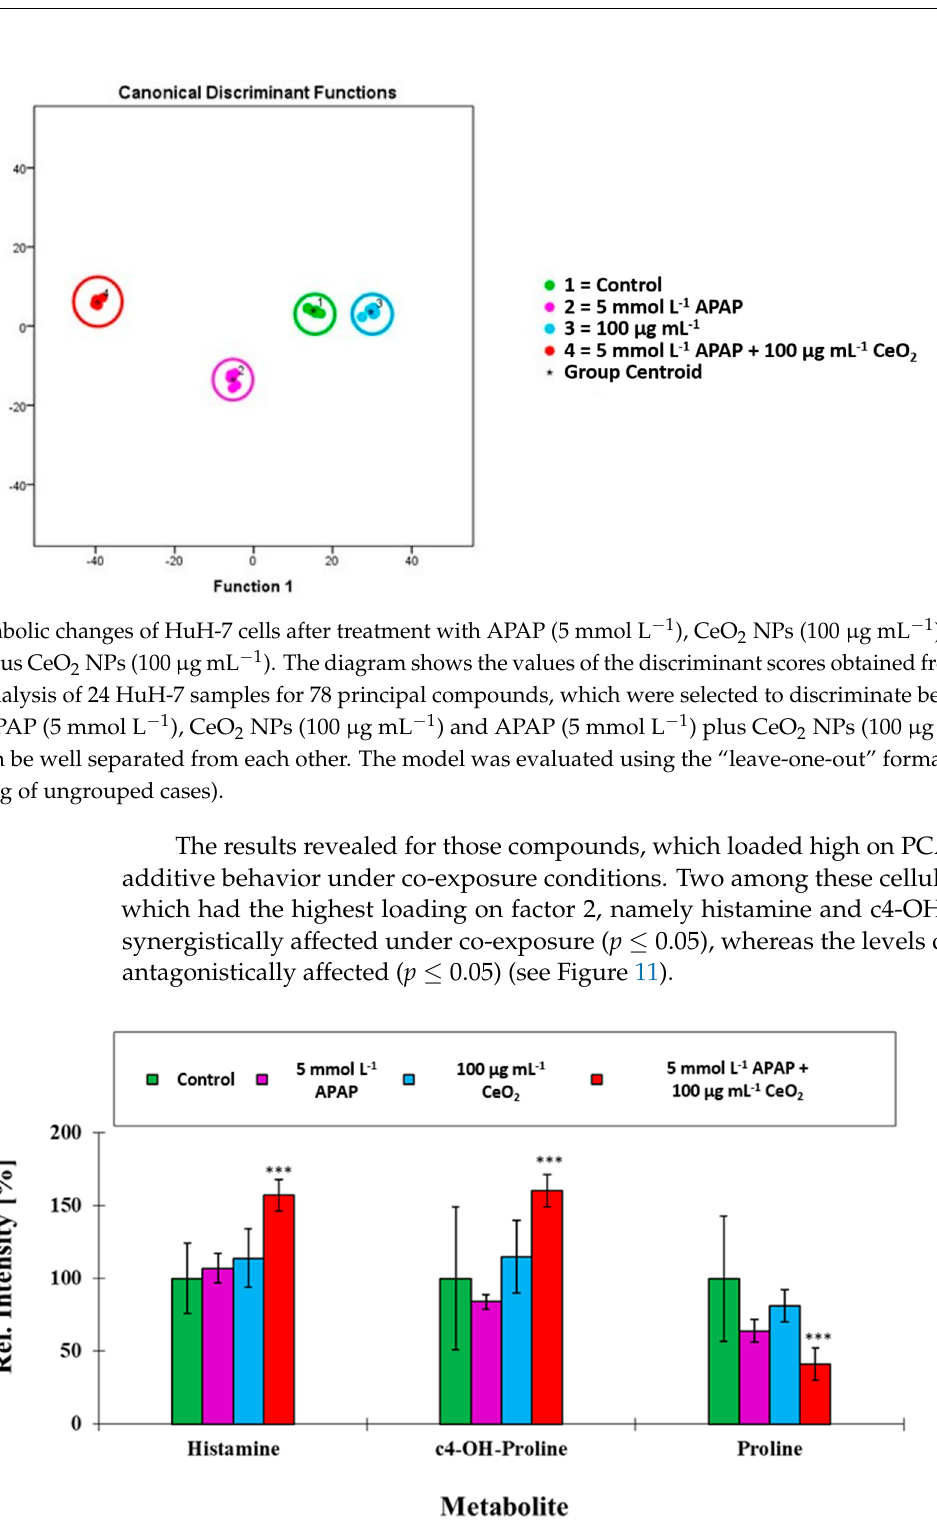
Figure 11. Comparison of ion yields for characteristic biomarker metabolites addressed in the targeted metabolomics experiment of cells co-exposed to APAP (5 mmol L − 1 ) and CeO 2 NPs (100 µ g mL − 1 ). These metabolites were used to separate the four treatment groups. The mean of the control group of unexposed HuH-7 cells was taken as 100% in all cases. ***: p ≤